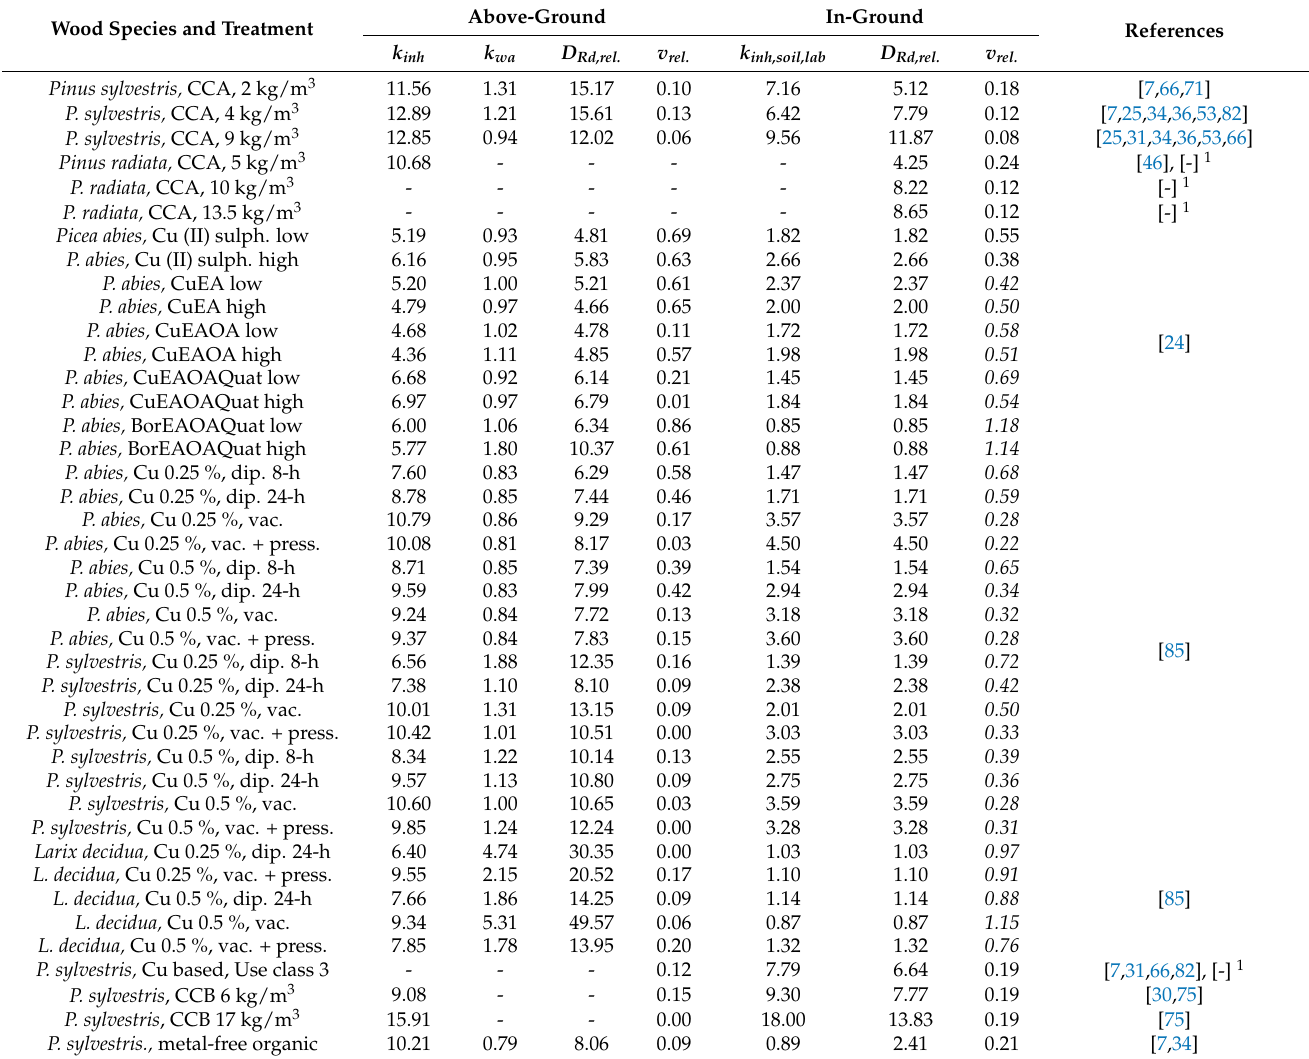
Table 4. Parameters for predicting the material resistance of preservative-treated timbers in- and above-ground. k inh = factor accounting for protective inherent properties based on white rot, brown rot, and soil contact tests; k inh,soil,lab = factor accounting for protective inherent properties based on laboratory test with soil contact and soft rot fungi; k wa = factor accounting for moisture performance (wetting ability); D Rd,rel. = relative resistance dose; v rel. = rela- tive decay rate; sw = sapwood; CCA = chromated copper arsenate; CCB = chromated copper borate; Cu = copper; EA = ethanolamine; OA = octanoic acid; Quat = quaternary ammonium compounds. Calculated v rel. in italics. Above-Ground In-Ground Wood Species and Treatment References k